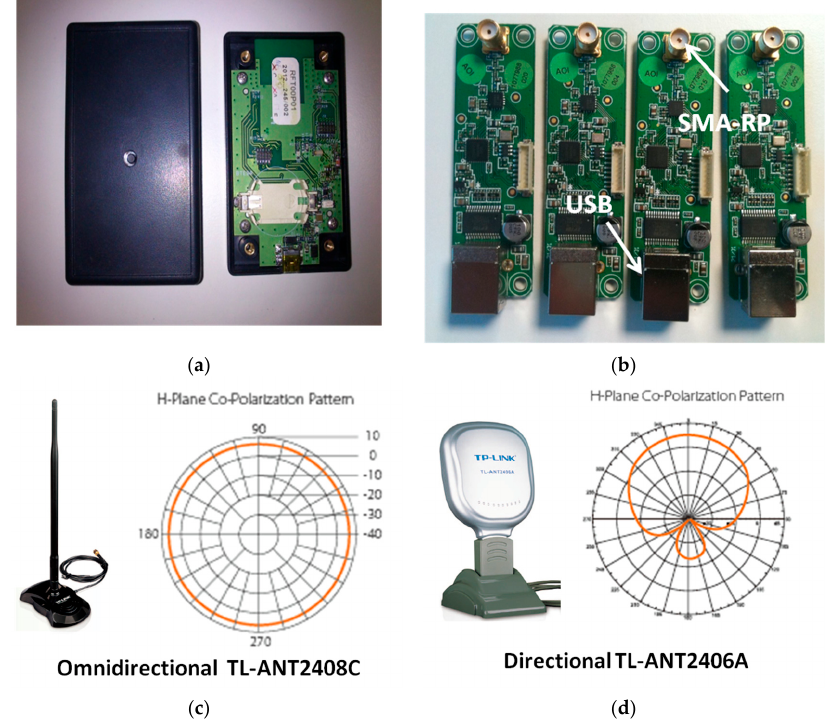
Figure 10. Hardware devices: ( a ) tag and ( b ) four sensor reader prototypes based on TI CC2510 modules. Employed commercial antennas (TP-Link): ( c ) omnidirectional TL-ANT2408C antenna and ( d ) directional TL-ANT2406A antenna with associated XY -plane radiation patterns (vertical polarization).